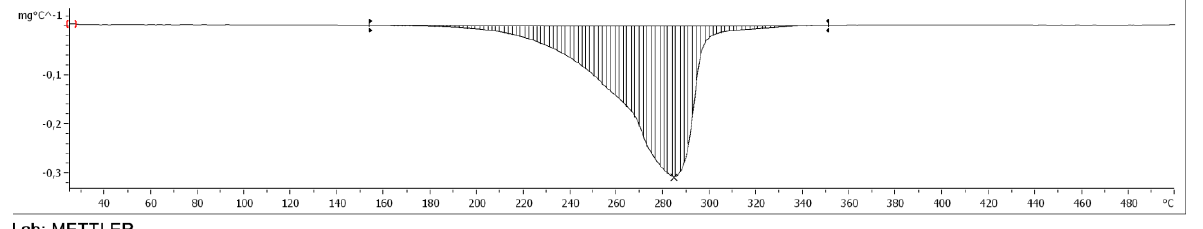
Figure 7. DSC curve of decyl butoxyethyl adipate.